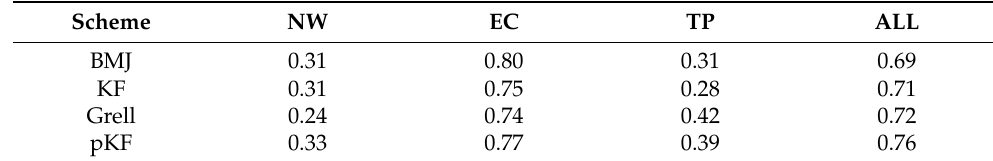
Table 1. Ensemble seasonal mean correlation coefficients (CR MO ) for Northwest China (NW), East China (EC), the Tibetan Plateau (TP), and the land portion of the model domain (ALL). Scheme NW EC TP ALL BMJ 0.31 0.80 0.31 0.69 KF 0.31 0.75 0.28 0.71 Grell 0.24 0.74 pKF 0.33 0.77 0.39